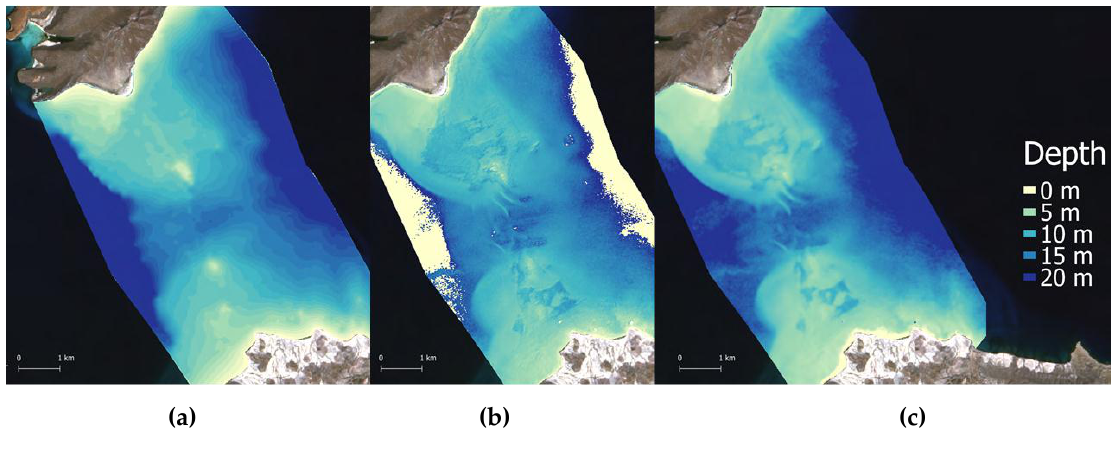
Figure 4. ( a ) is the interpolated DTM of groundtruthed depth points; ( b ) is 4SM satellite retrieved depth layer from 19 October 2013; ( c ) is satellite retrieved depth layer processed with ENVI-SPEAR tool on the same scene.